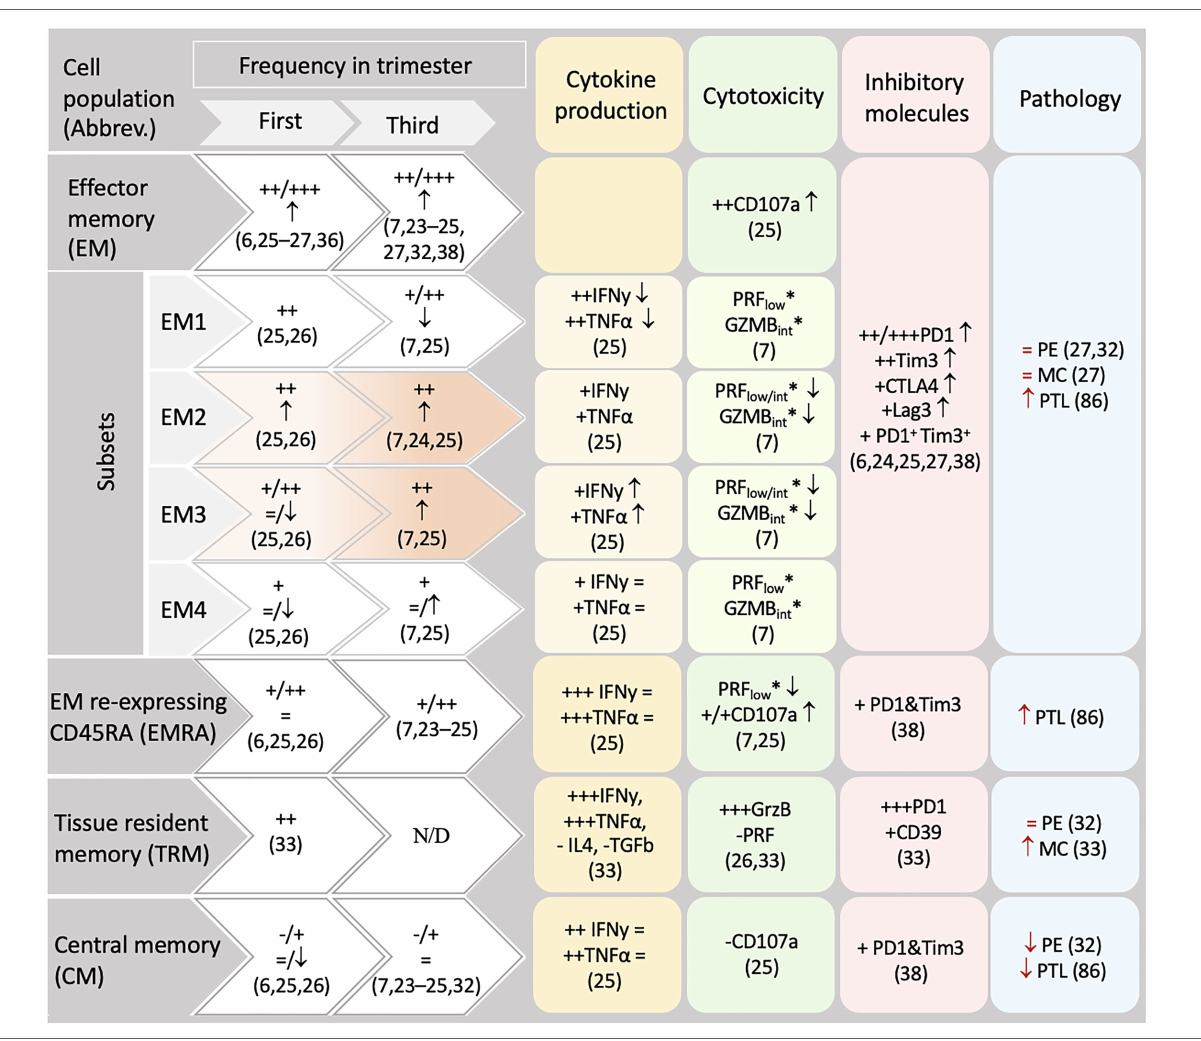
TABLE 1 | CD8+ memory populations in human